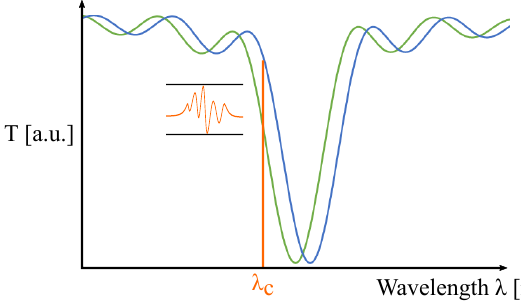
Figure 24. A schematic of a light intensity measurement.